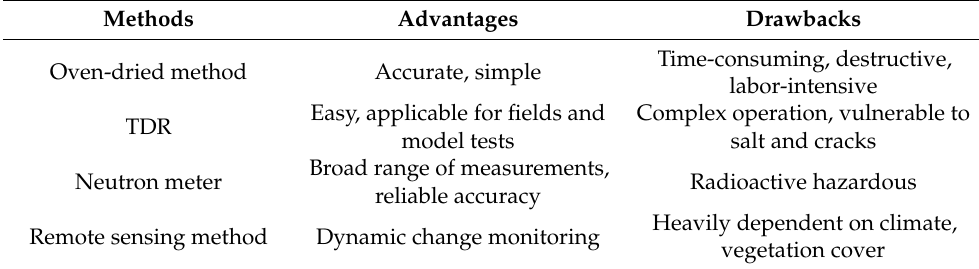
Table 1. A summary of different methods to measure SWC. Methods Advantages Drawbacks Oven-dried method Accurate,